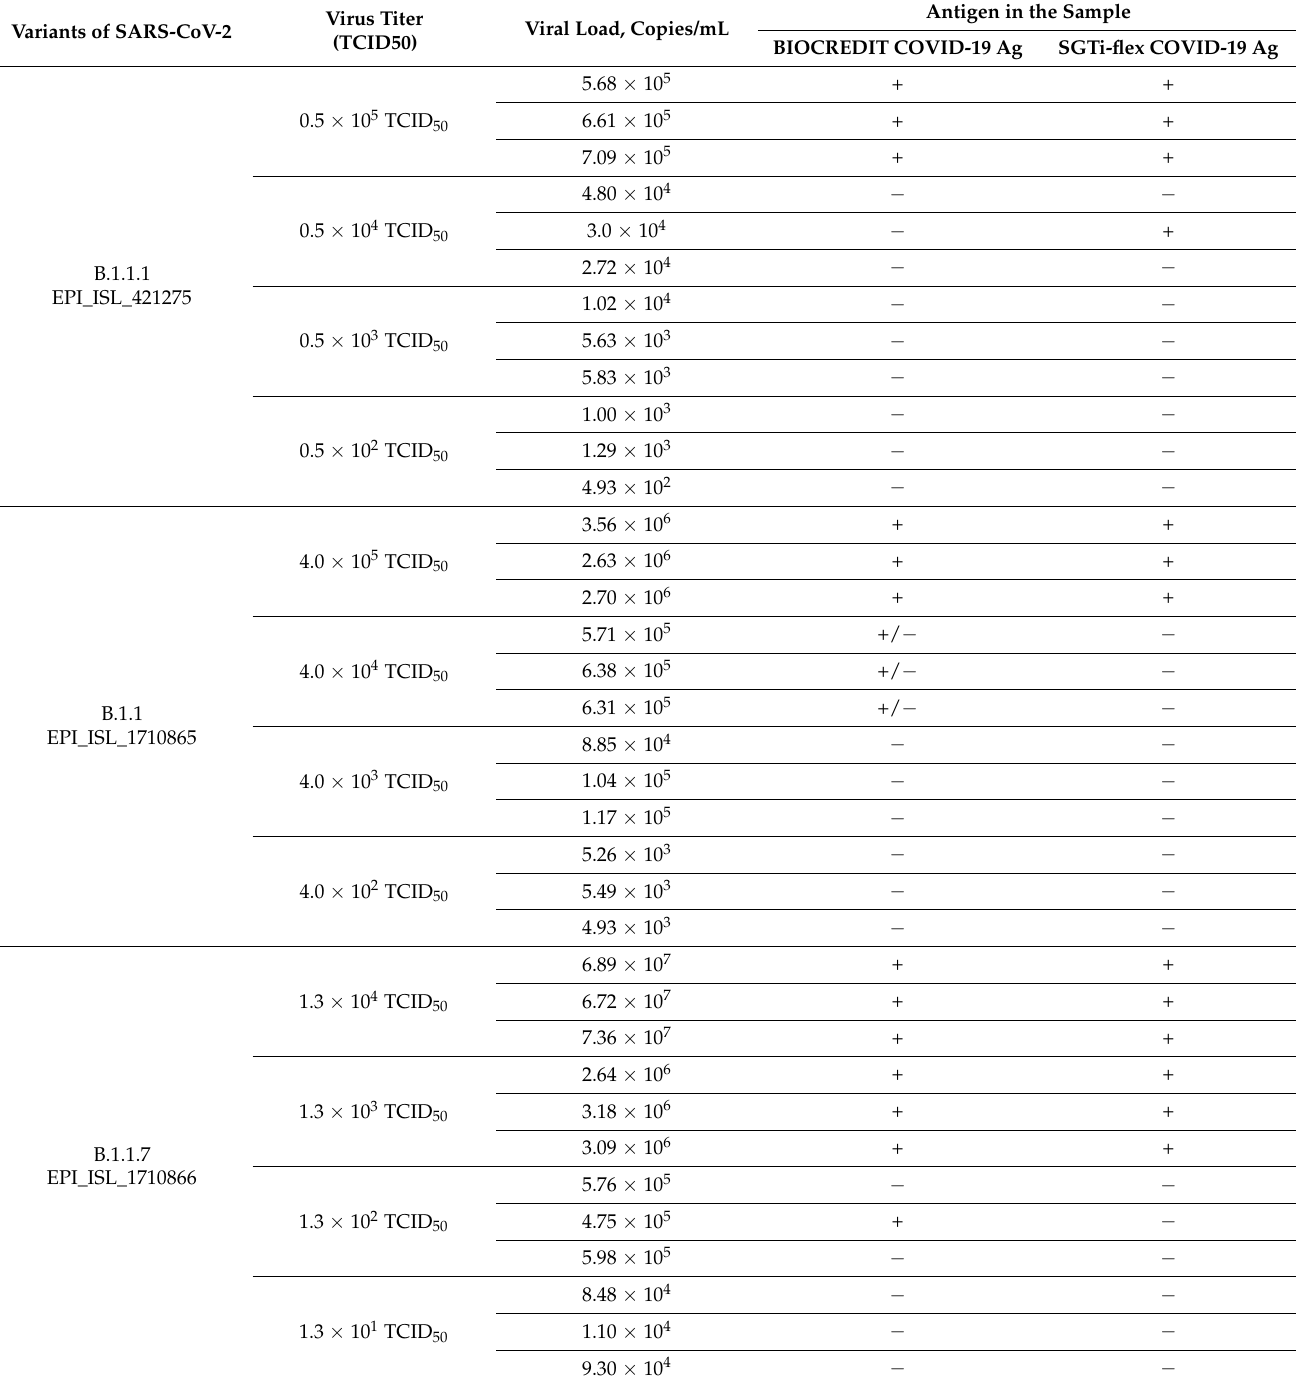
Table A1. Sensitivity of BIOCREDIT COVID-19 Ag and SGTI-flex COVID-19 Ag tests with SARS-CoV-2 variants. Variants of